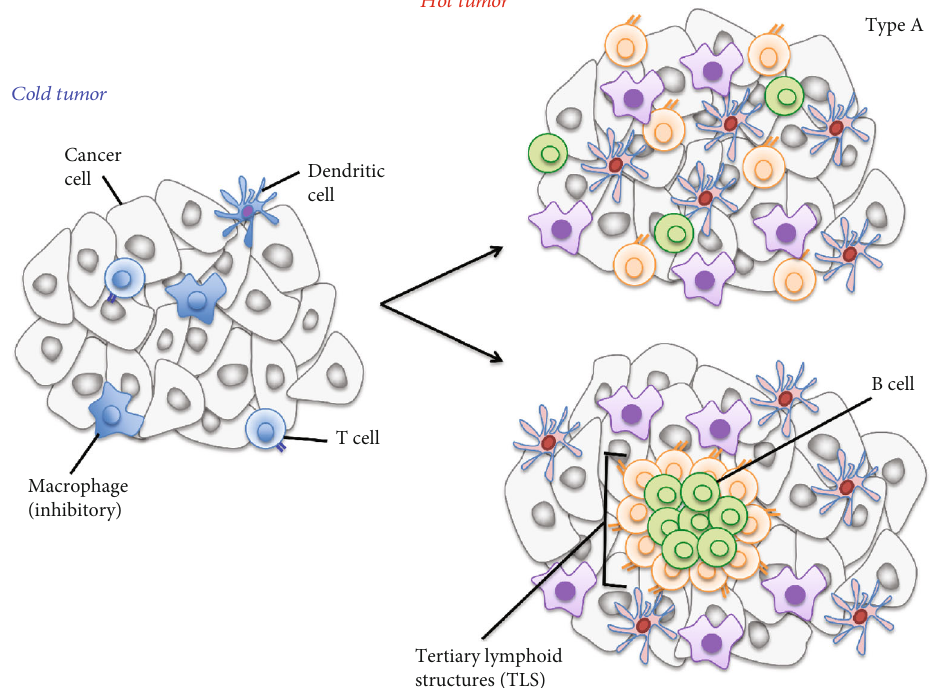
Figure 2: Classi fi cation of tumors by immune cell in fi ltration. Tumor types can be classi fi ed by the level of immune cell in fi ltration into tumors. “ Cold tumor, ” characterized by the poor in fi ltration of immune cells, is reported to be one of the reasons why immune checkpoint inhibitors are ine ff ective. Contrastingly, a “ hot tumor ” is characterized by the abundant in fi ltration of immunocompetent cells, showing good responses to immune checkpoint inhibitors. Recently, aggregated in fi ltration of immune cells, known as the tertiary lymphoid structure (hot tumor, type B), has gained increasing attention compared to separated in fi ltration of immune cells (hot tumor, type